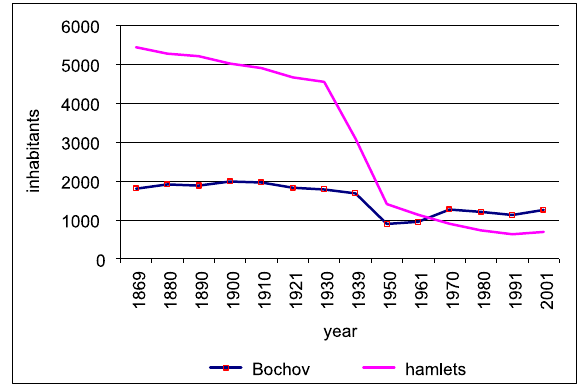
Fig. 6. Case of the Bochov micro-region (W Bohemia): population development in the central place and surrounding villages in 1869–2001. Source: Perlingerová – Vaishar (2012).